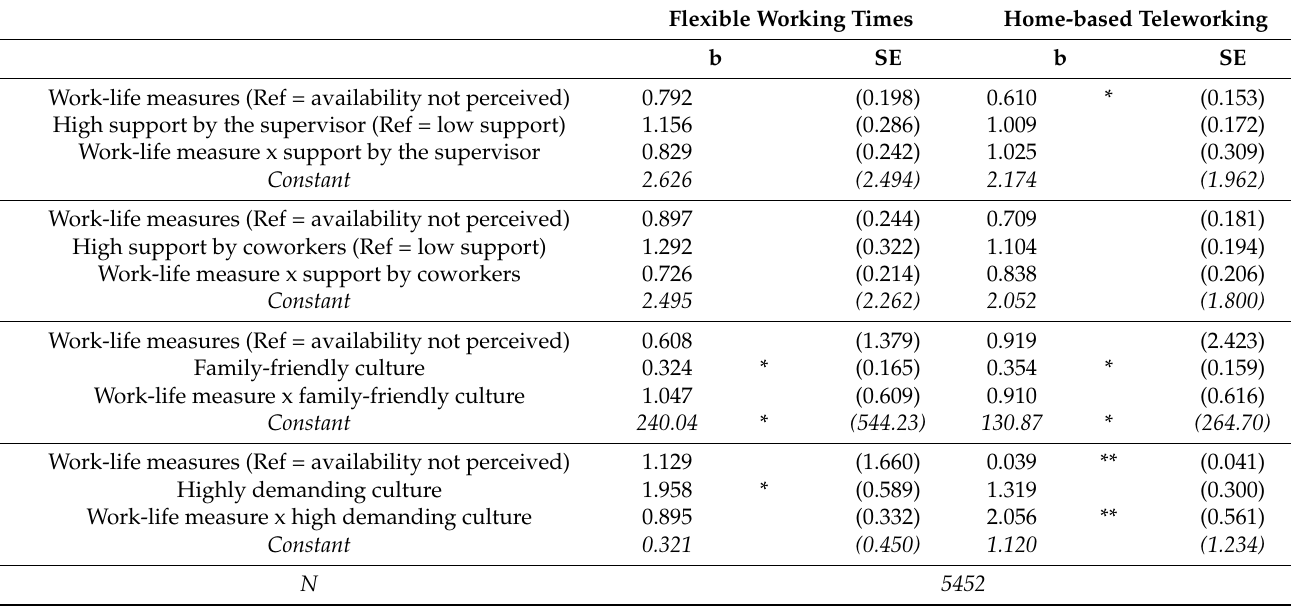
Table 3. The moderating effect of the organizational environment on the association between flexibility measures and voluntary employee exit (logistic regression with organizational mixed effects and clustered standard errors; odds ratios). Flexible Working Times Home-based